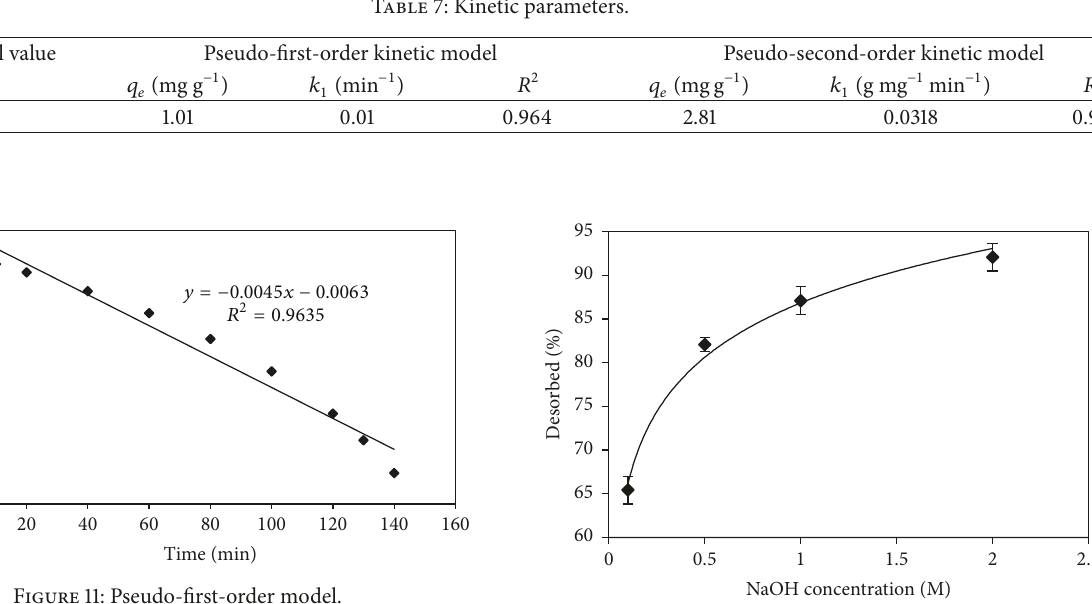
Figure 13: Desorption of Ca(II) ions from the spent